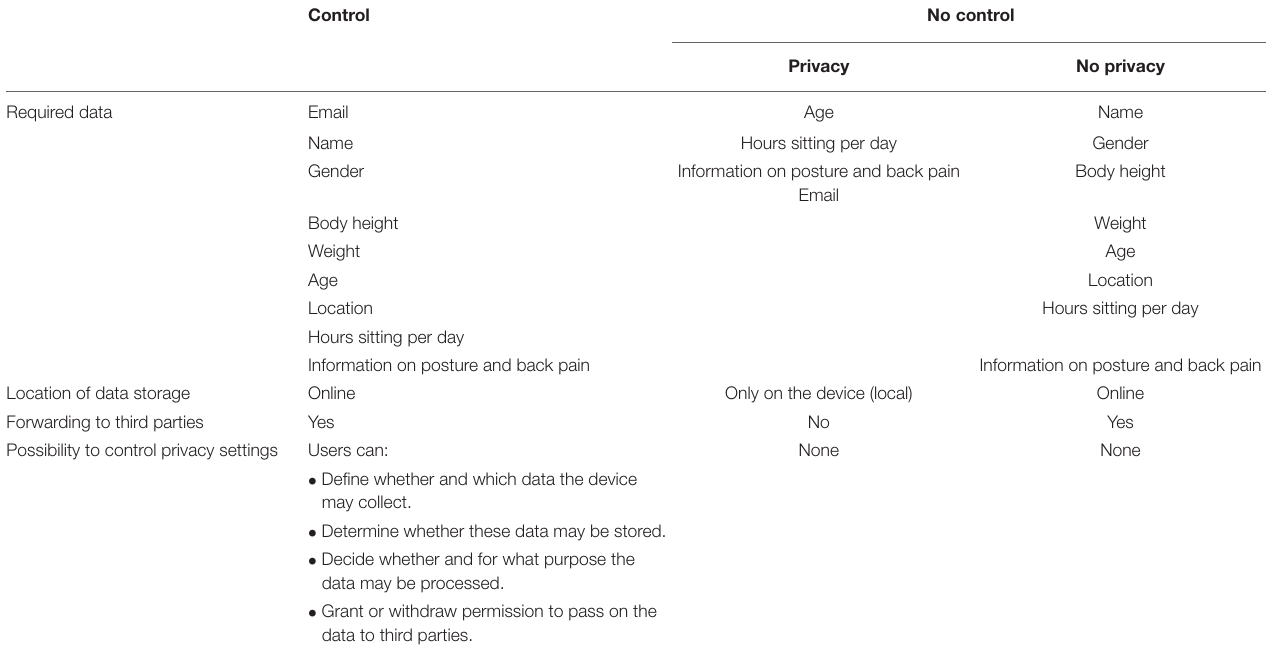
TABLE 1 | Design of the